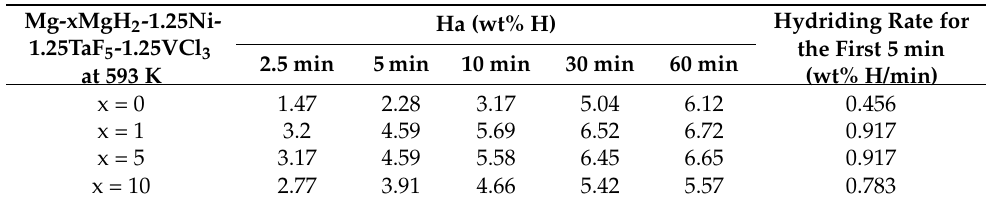
Table 1. Variations of the Ha with time and hydriding rates for the first 5 min at 593 K under 12 bar H 2 at n = 1 for Mg-xMgH 2 -1.25Ni-1.25TaF 5 -1.25VCl 3 (x = 0, 1, 5, and 10). Mg-xMgH 2 -1.25Ni-